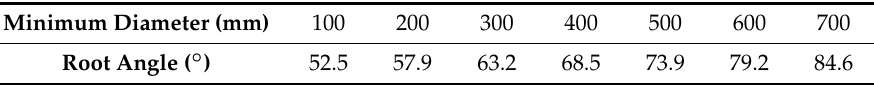
Table 1. The threshold of diameters and root angles at the cut